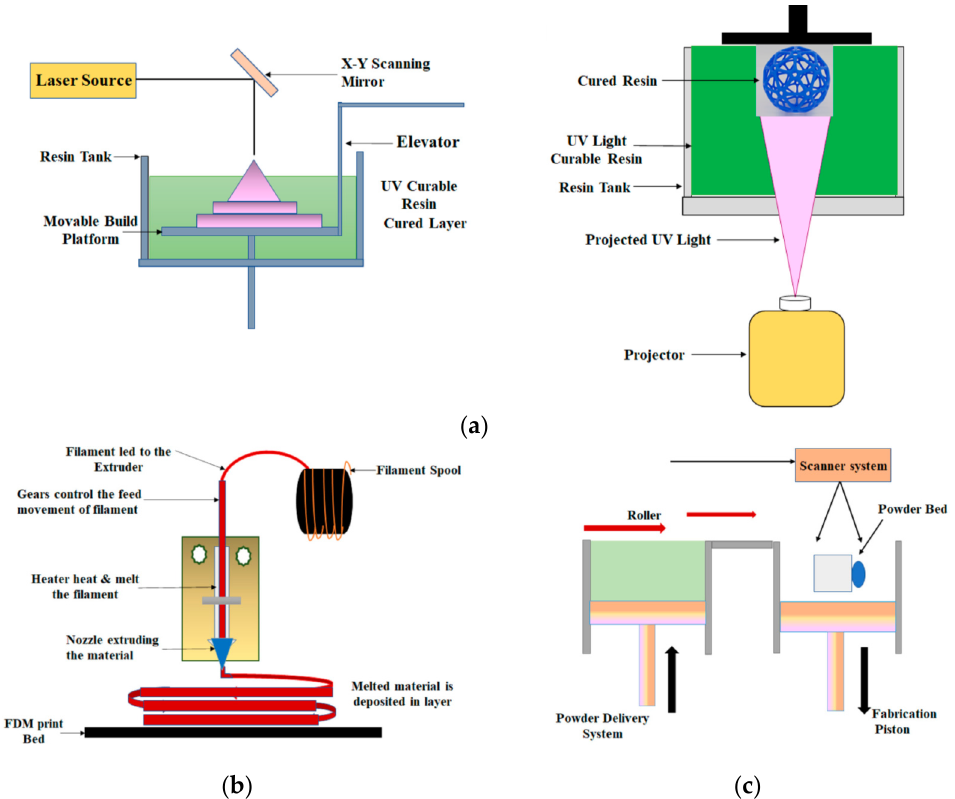
Figure 7. Schematic showing the setup for ( a ) stereolithography, ( b ) fused deposition modeling, and ( c ) selective laser sintering. Adapted, with permission, from [105]. 2021, Frontiers.